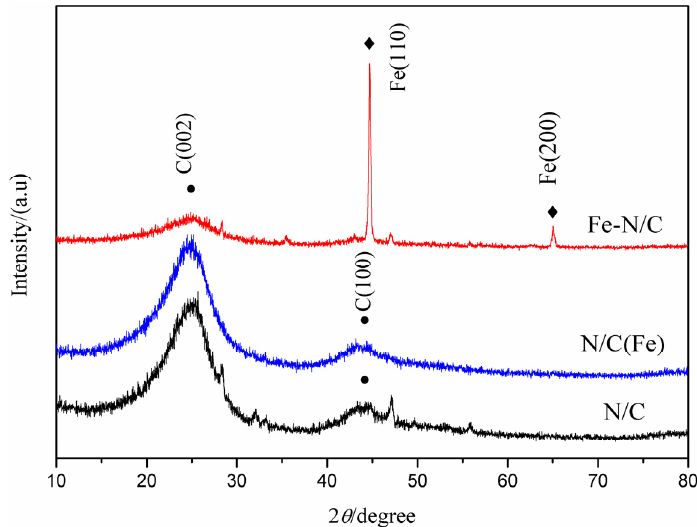
Figure 5. XRD patterns of N/C, Fe–N/C and N/C (Fe).